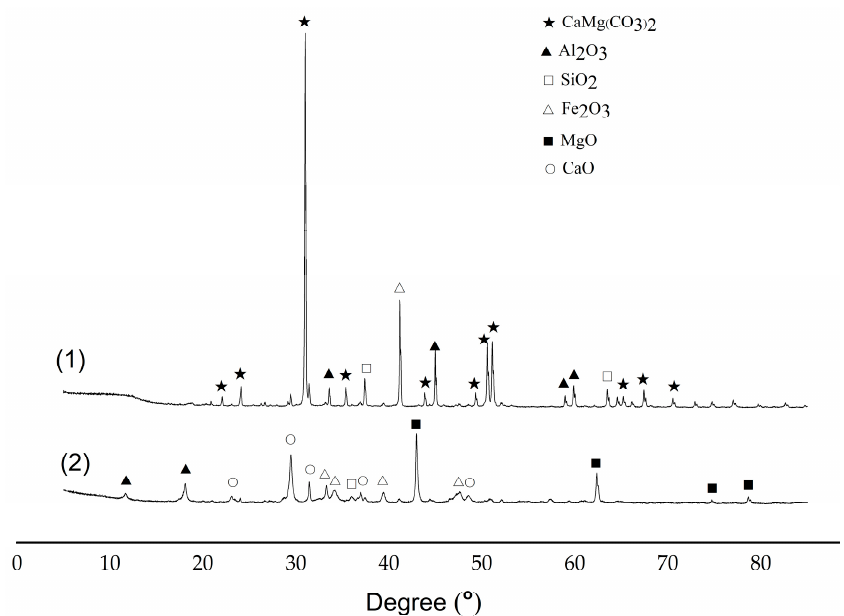
Figure 6. XRD patterns of dolomite (1) and calcined dolomite (2). Table 3. The surface characterization of dolomite and calcined